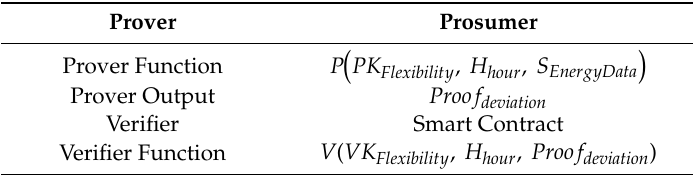
Table 2. Prover and verifier functions for ZK proofs.